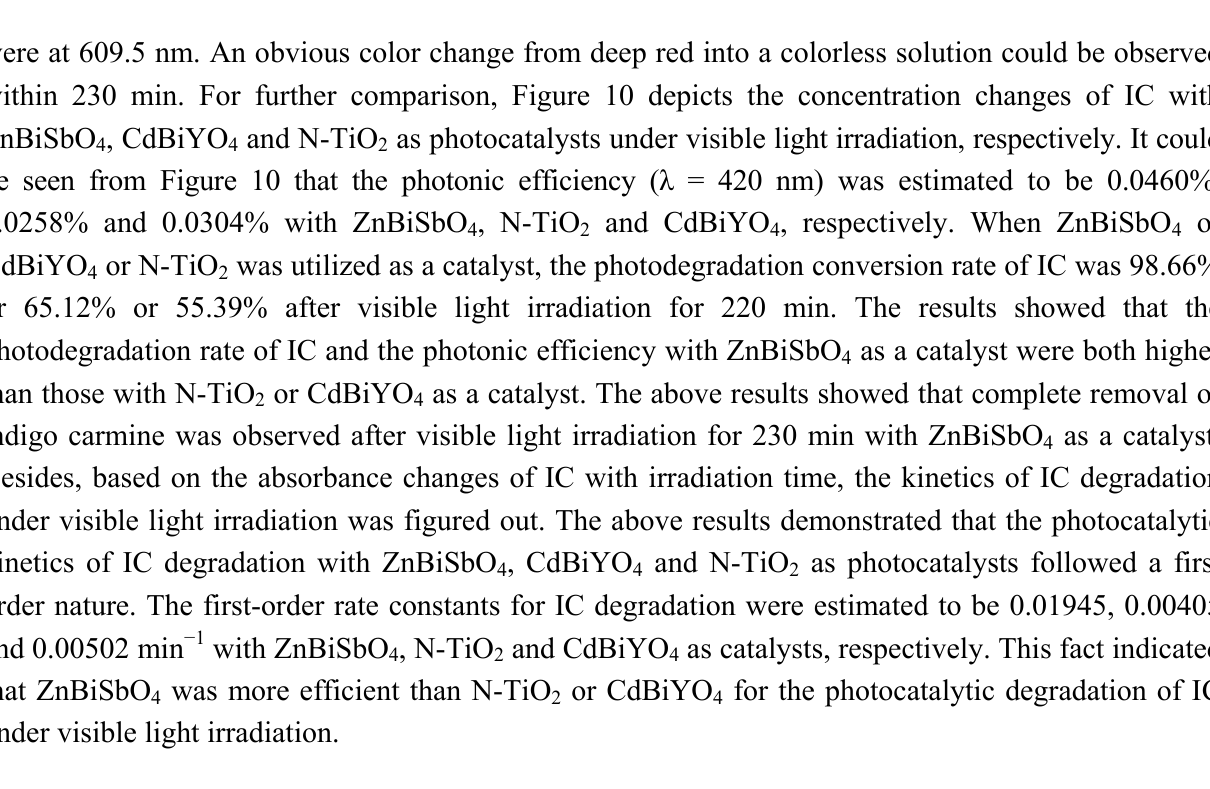
Figure 9. Spectral changes of aqueous solutions of indigo carmine (IC) due to visible light irradiation with the presence of ZnBiSbO